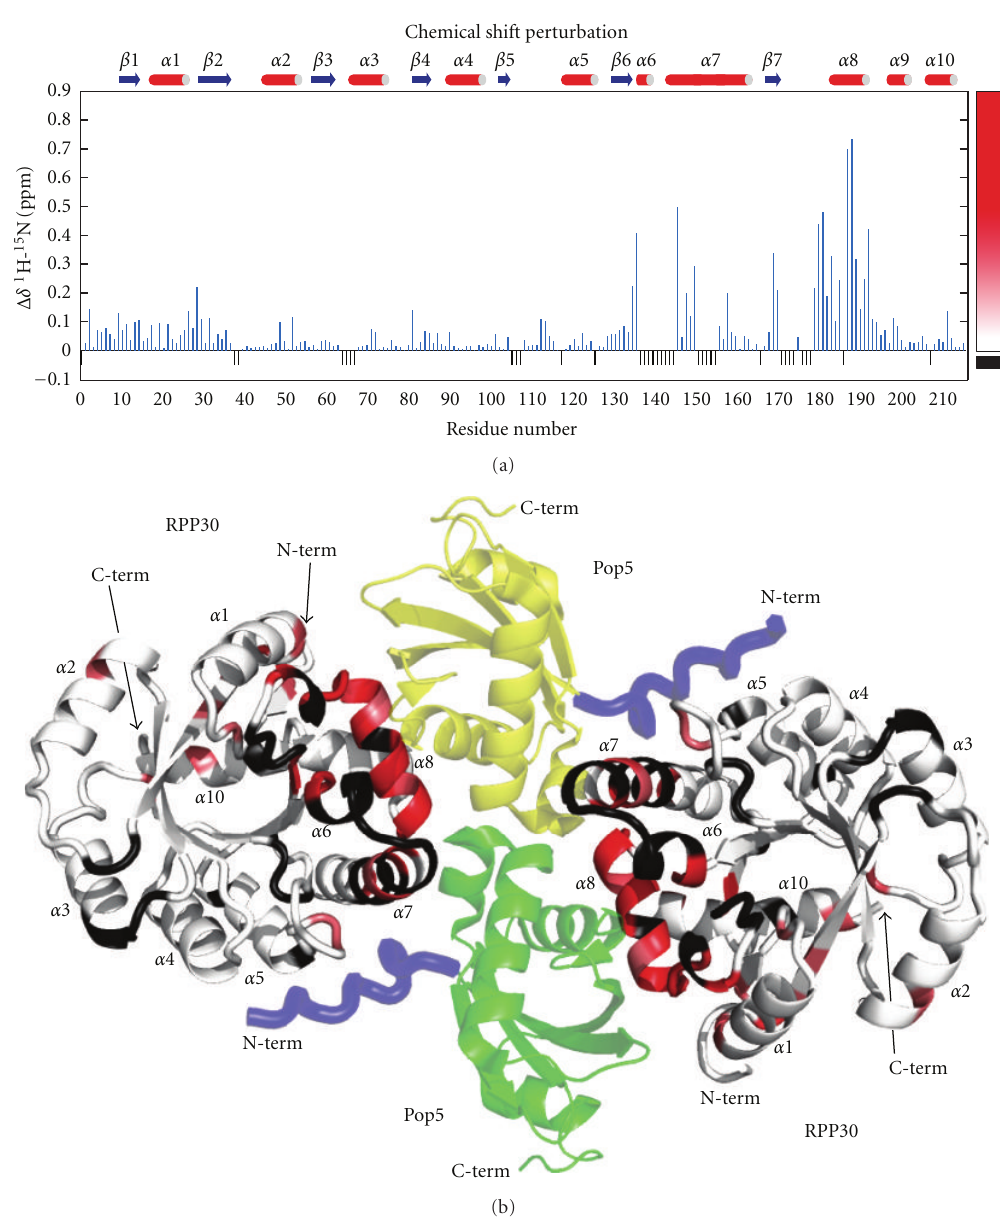
Figure 7: Chemical shift perturbations on RPP30 induced by Pop5 binding. (a) Secondary structure and per residue weighted average amide (cid:2) 1 H and 15 N chemical shift perturbations Δ δ = 0 . 5( Δ δ 2 + ( Δ δ N / 5) 2 ) [20]. The color gradient used for mapping the data to the structure is H shown on the right. Small black negative bars indicate residues for which the free and Pop5-bound RPP30 shifts could not be compared due to incomplete assignments or proline residues. (b) Cartoon diagram of a homology model of the Pfu Pop5-RPP30 complex based on the crystal structure of the complex from Pho [14]. Protomers of RPP30 are colored from white to red according to increasing shift perturbation. Black indicates no CSP data. The two protomers of Pop5 in the heterotetramer are green and yellow. An N-terminal segment observed in the Pho Pop5-RPP30 crystal structure, but not the Pfu Pop5 structure, is shown in blue.